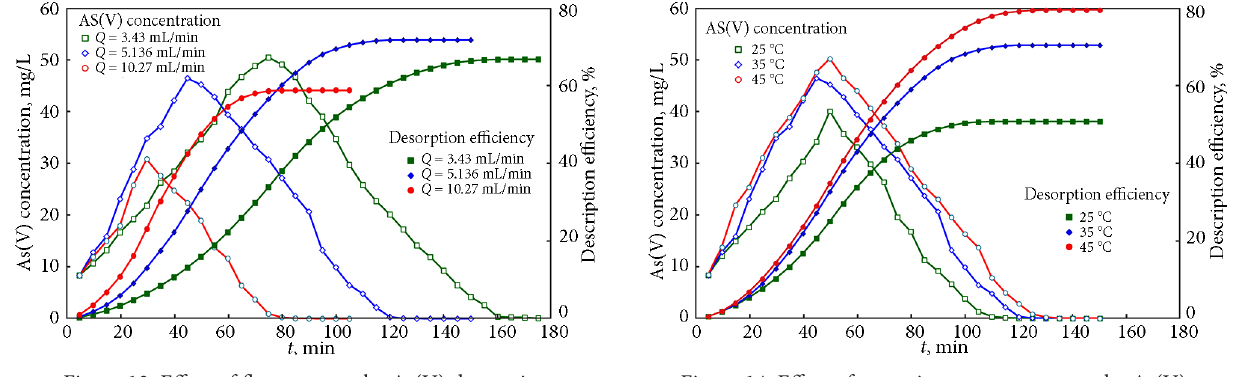
Figure 14. Effect of operating temperature on the As(V) mesh)Figure 13. Effect of flow rate on the As(V) desorption desorption efficiencies (eluent concentration: 0.1 mol/L NaOH; efficiencies (eluent concentration: 0.1 mol/L NaOH; adsorbent flow rate: 5.136 mL/min; adsorbent mass: 2 g; adsorbent grain mass: 2 g; adsorbent grain size: <100 mesh; operating size: <100 temperature: 35